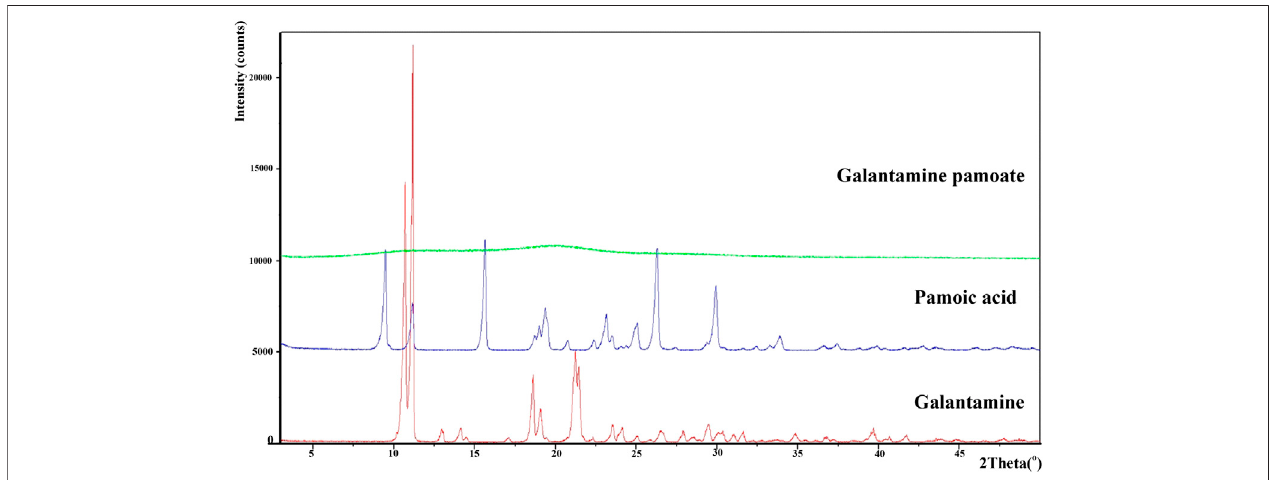
FIGURE 3 | X-ray diffractogram of galantamine, pamoic acid and GLT-PM.